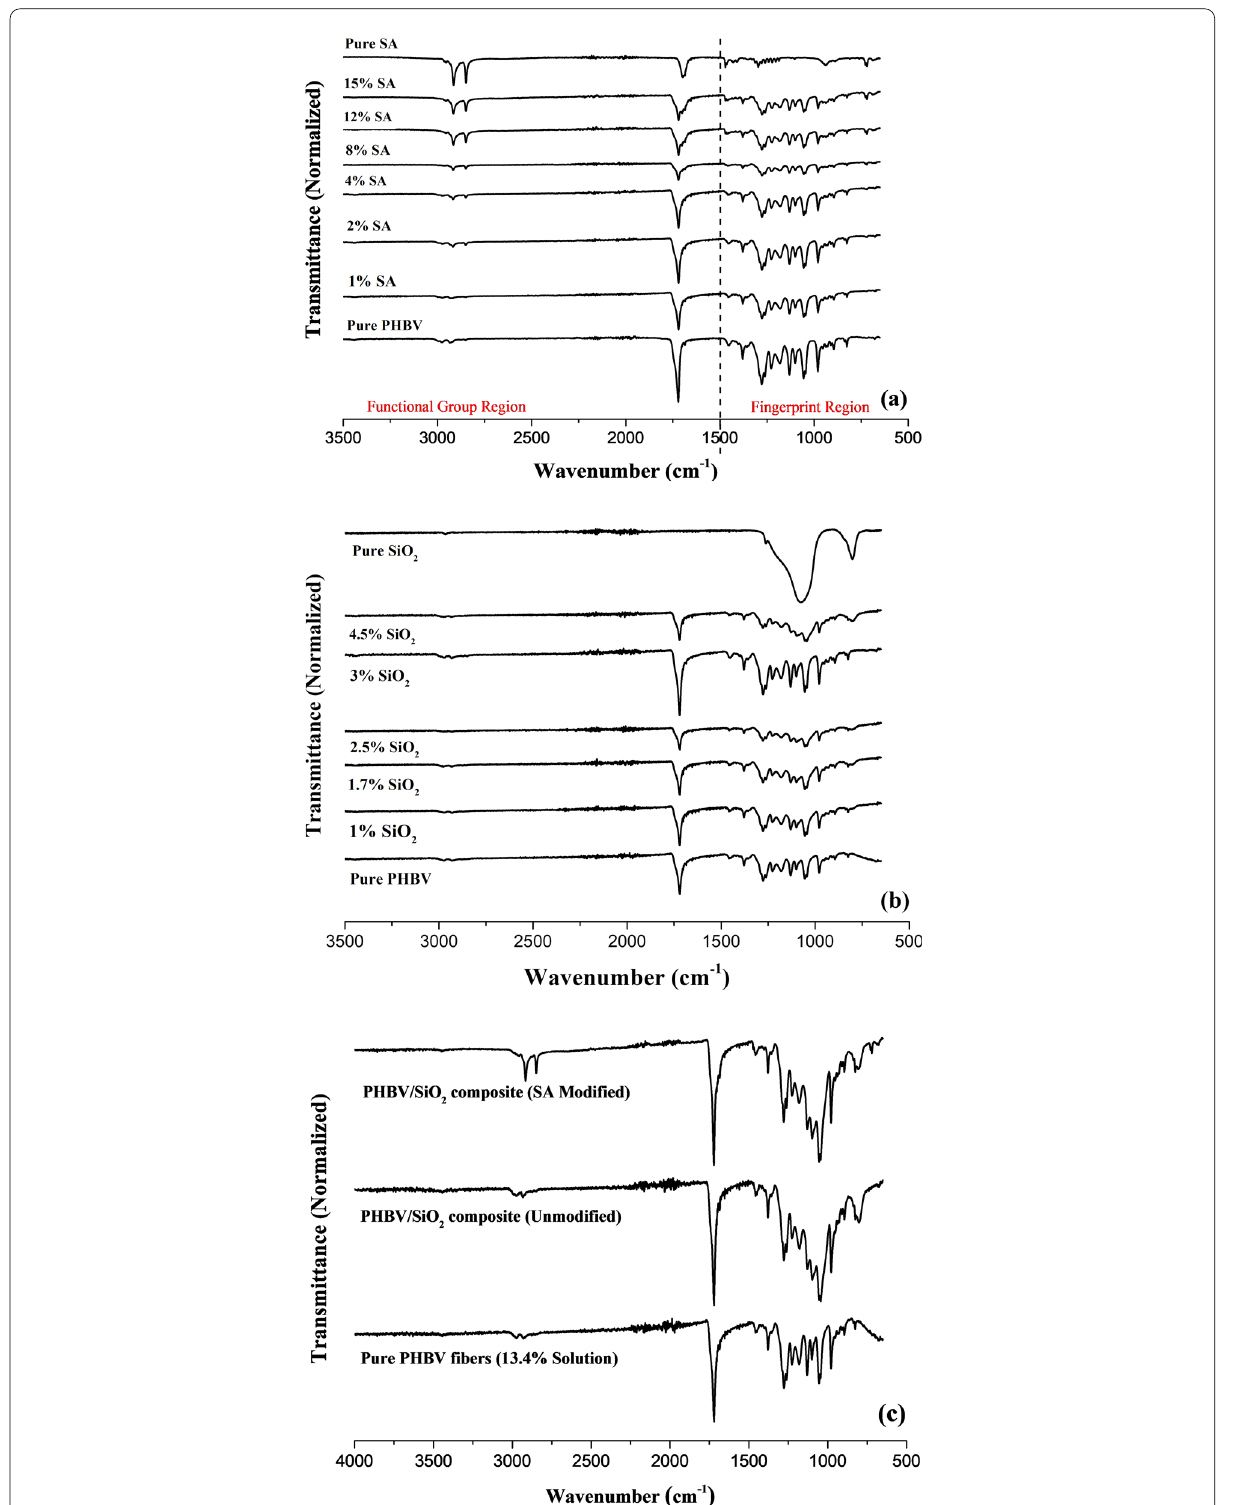
Fig. 7 FTIR of a SA modification on PHBV fibers; b PHBV/SiO 2 composite fibers and c synergic effect of SiO 2 incorporation and SA modification on PHBV